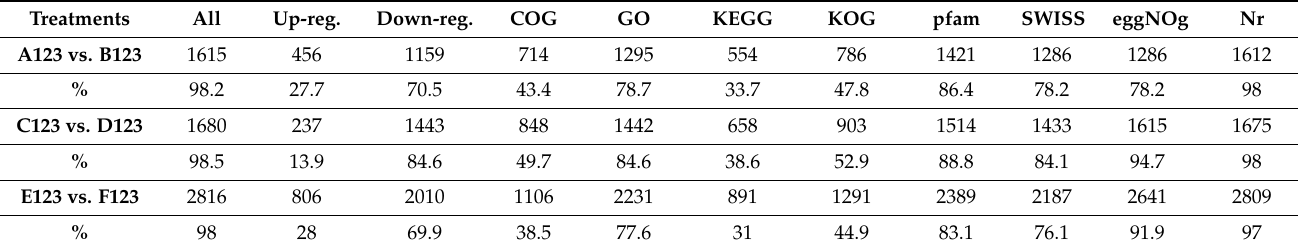
Table 3. Summary of annotated DEGs at three different points.